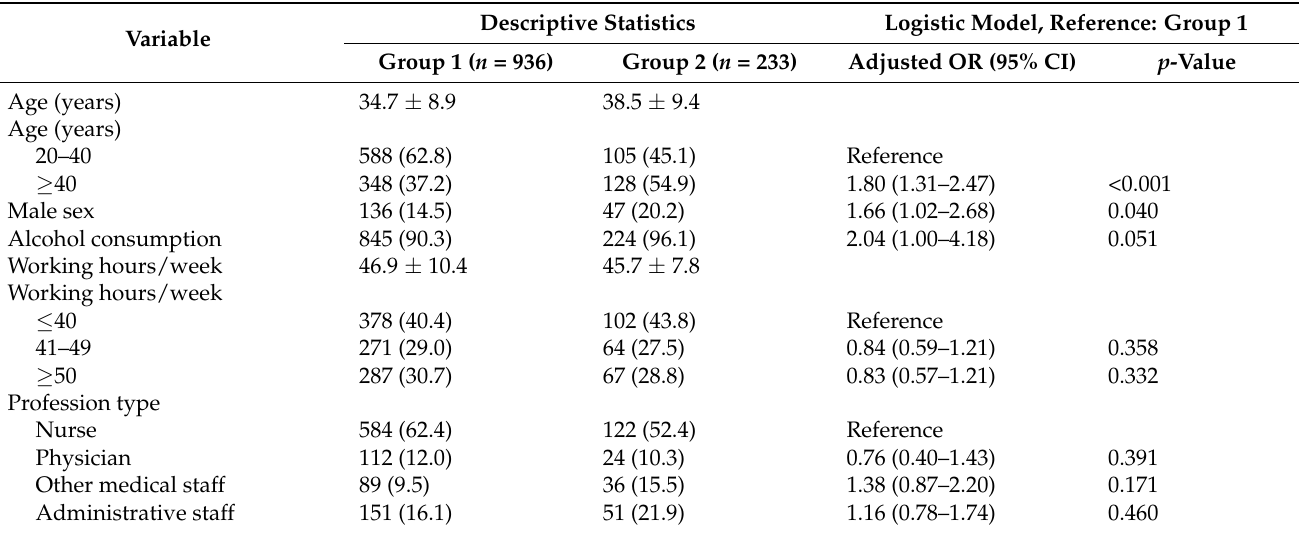
Table 2. Basic demographics of the study population according to the latent classes of developmental trajectories for MUNO in the longitudinal